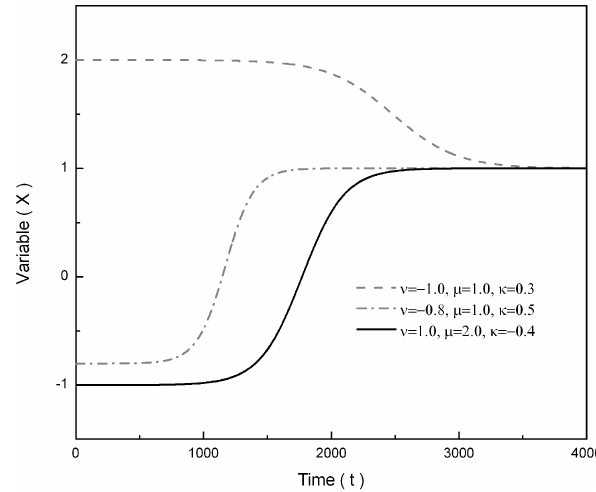
Figure 1. The evolution of the system over time, com- puted by rewriting Eq. (1) as its difference